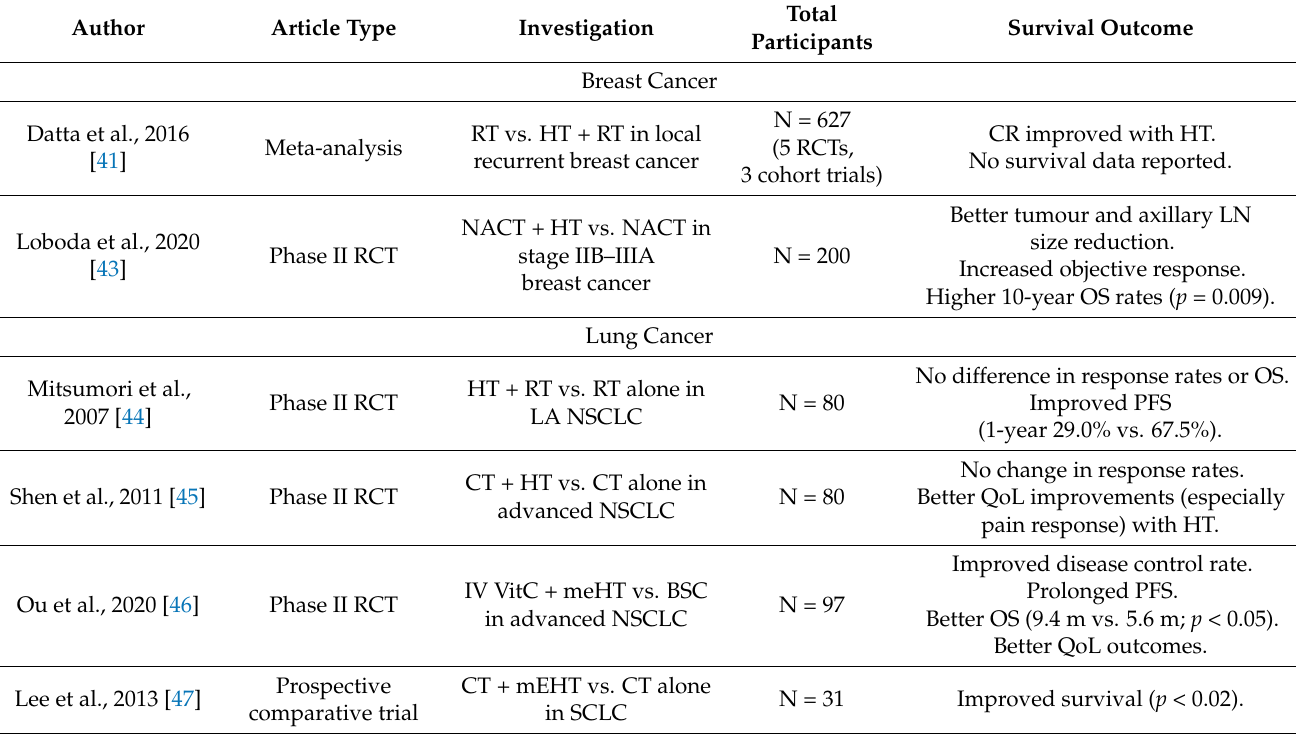
Table 2. HT in patients with breast and lung cancers. Summary of articles